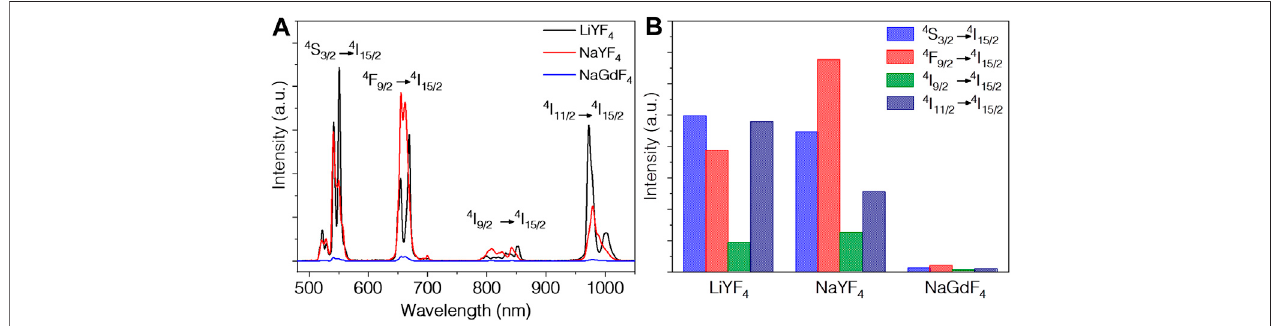
FIGURE 2 | (A) UC emission spectra and (B) integration of all peaks of LiYF